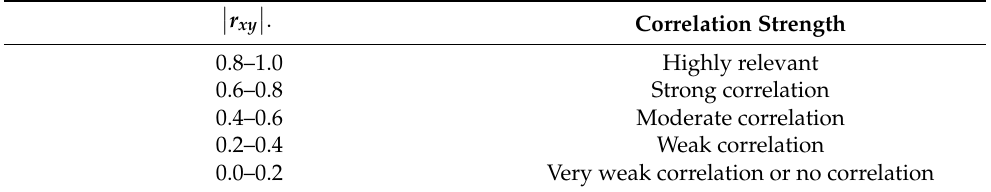
(cid:12) (cid:12) (cid:12) r xy (cid:12) and correlation strength.